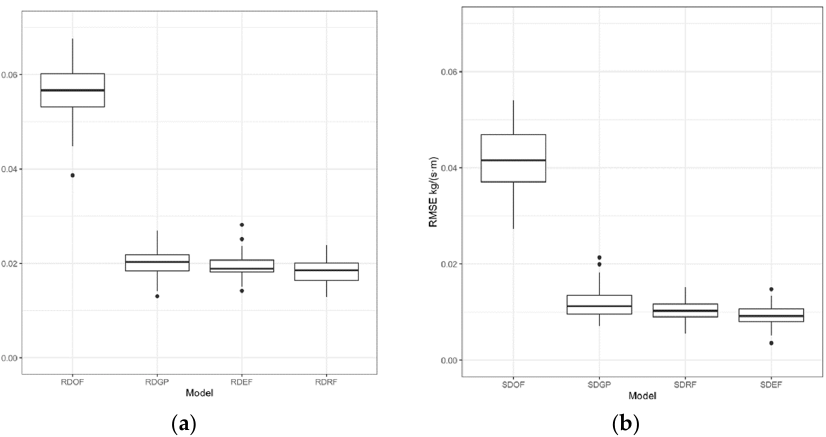
Figure 2. Boxplots for: ( a ) out-of-the-bag RMSE for all methods and bootstrapping repetitions using raw data; ( b ) out-of-the-bag RMSE for all methods and bootstrapping repetitions using smoothed data.